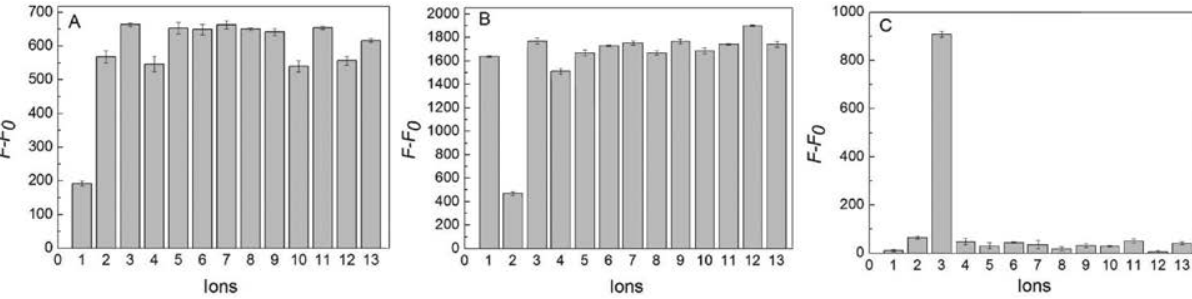
Figure 6. Selective detection of three metal ions at (A) λ ex = 353 nm, λ em = 450 nm; (B) λ ex = 495 nm, λ em = 517 nm; (C) λ ex = 530 nm, λ em = 580 nm. 1-13: Pb 2+ , Ag + , Hg 2+ , Mg 2+ , Ca 2+ , Fe 3+ , Co 2+ , Ni 2+ , Zn 2+ , Cd 2+ , Al 3+ , Cr 3+ , Cu 2+ . The concentrations of Pb 2+ , Ag + , Hg 2+ to be measured were 1 μM, and the concentrations of other metal ions were 10 µM. F is measured fluorescence intensity, F 0 is background fluorescence intensity.